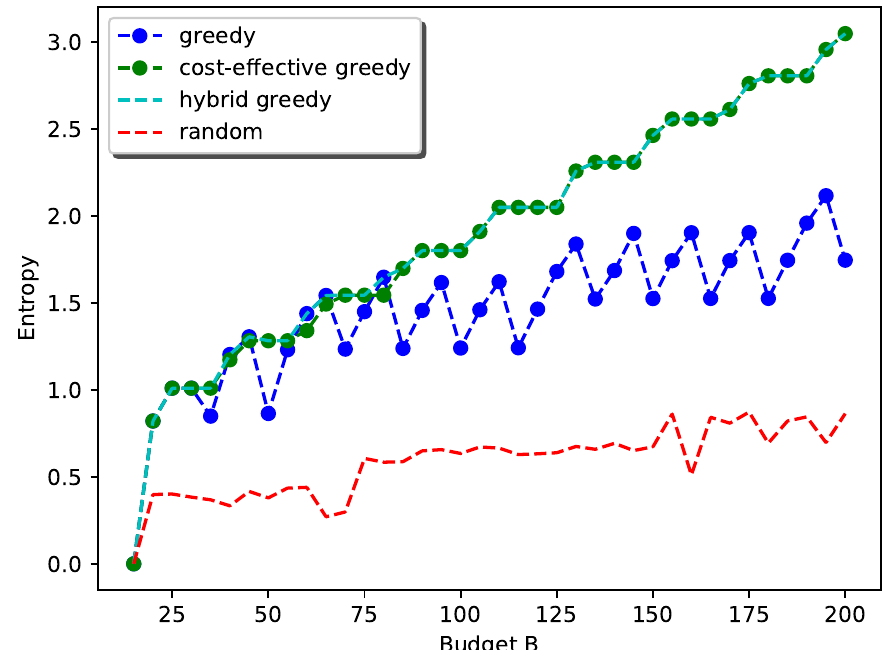
Figure 8. Performance of the hybrid greedy approach with equal weight w i